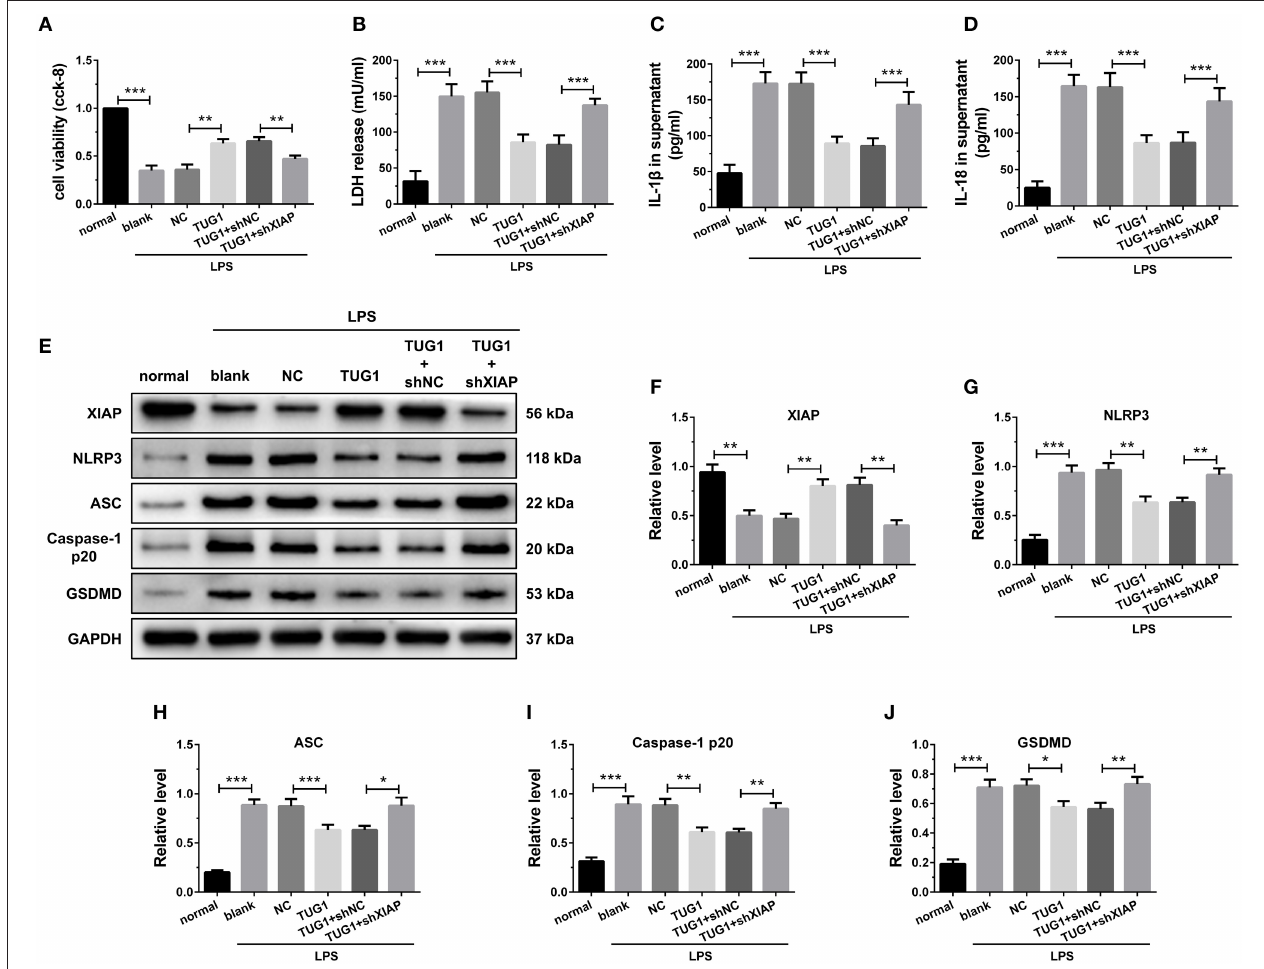
FIGURE 8 | Overexpression of TUG1 suppressed cardiomyocyte pyroptosis through regulation of XIAP. (A) A CCK-8 assay used to gauge H9C2 cardiomyocyte viability ( n = 3). Supernatant (B) LDH, (C) IL-1 β , and (D) IL-18 levels were measured via ELISA ( n = 6). (E-J) Western blotting was used to quantify cardiomyocyte XIAP, NLRP3, ASC, caspase-1 p20, and GSDMD protein levels with GAPDH as a loading control ( n = 3). Data are mean ± SEM from three or more independent experiments. * P < 0.05, ** P < 0.01, *** P <